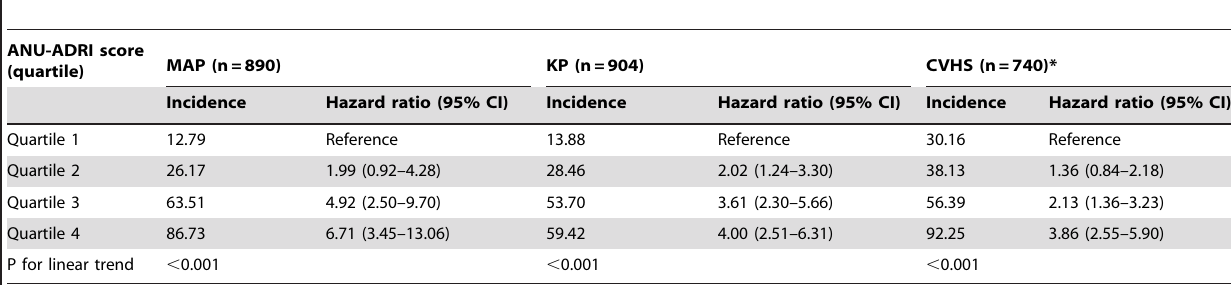
Table 4. Incidence of AD (per 1000 person-years) and hazards ratios for AD by quartile of ANU-ADRI score.